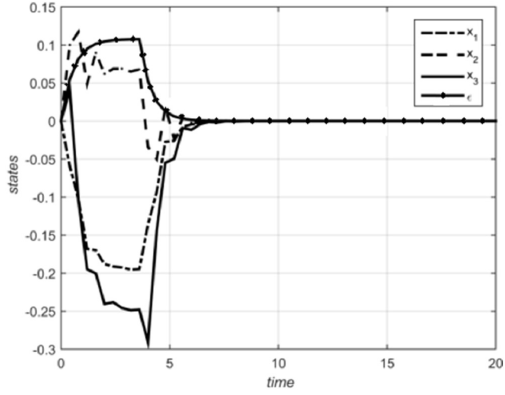
Figure 3. Trajectories of the